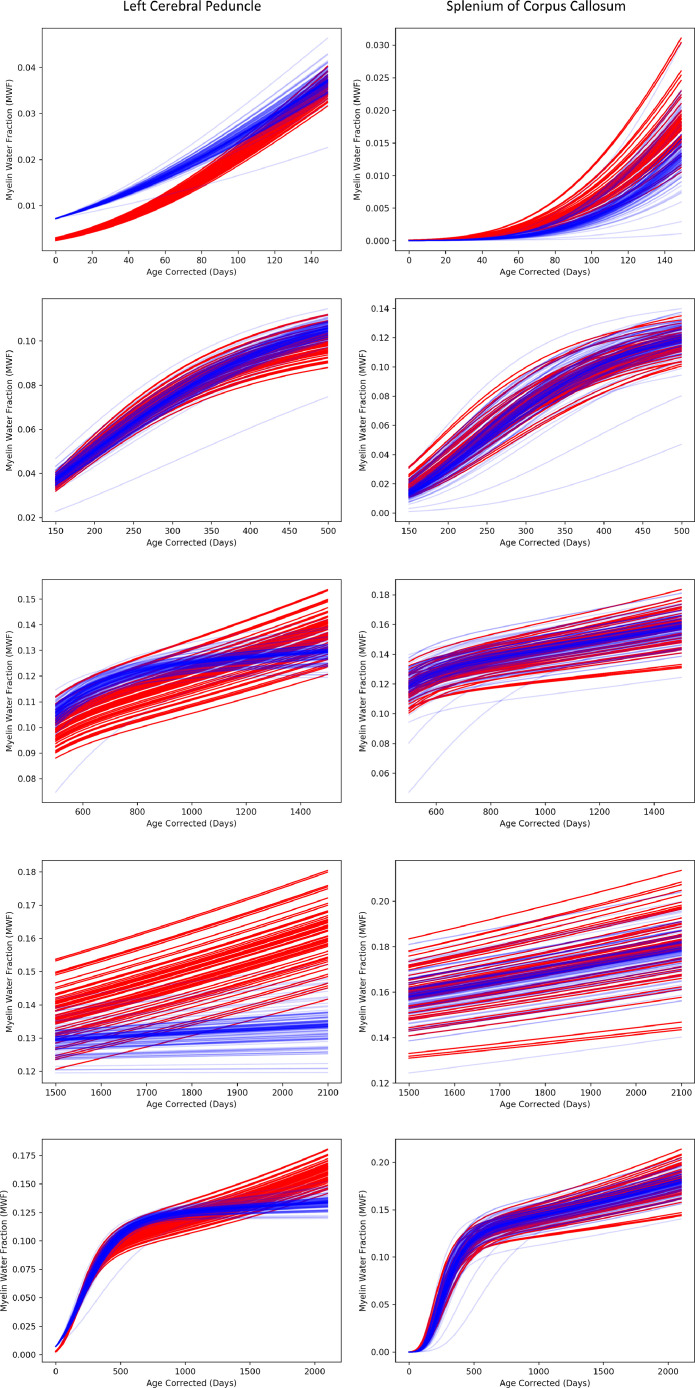
Reconstructed longitudinal MWF trajectories for each participant revealing differential neurodevelopment in the left cerebral peduncle and splenium of the corpus callosum. The red trajectories represent ε4 carriers and the blue trajectories represent non-carriers. The first row shows differences between ε4 carriers and non-carriers in the β parameter, he second row shows differences in the γ parameter; the third row shows differences in the α parameter; and the fourth row shows differences in η parameter. The final row shows the overall MWF trajectories for each participant. Significant differences was observed between all 4 parameters in the left cerebral peduncle; while significant difference in the splenium of the corpus callosum was only observed between the β (first row) γ (second row), and α (third row) parameter.